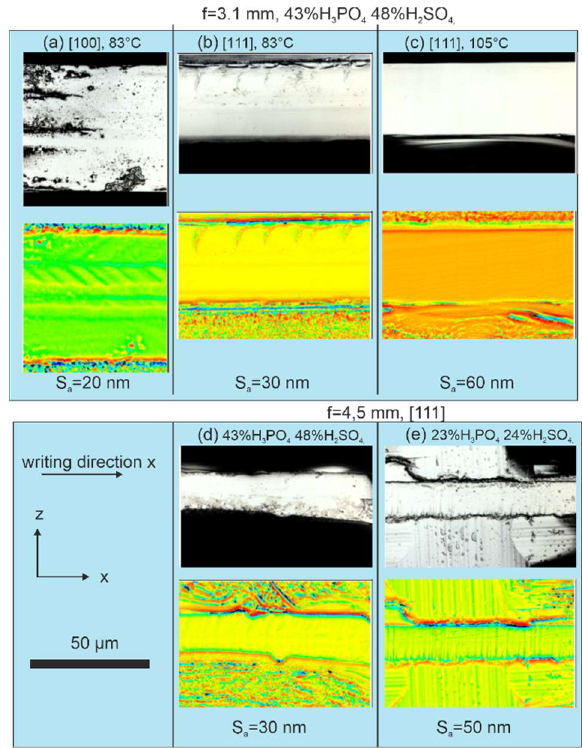
Fig. 4. Laser scanning microscope images of the opened selectively etched channels of regime 1 inscribed at 10 MHz. The different processing parameters are denoted in each